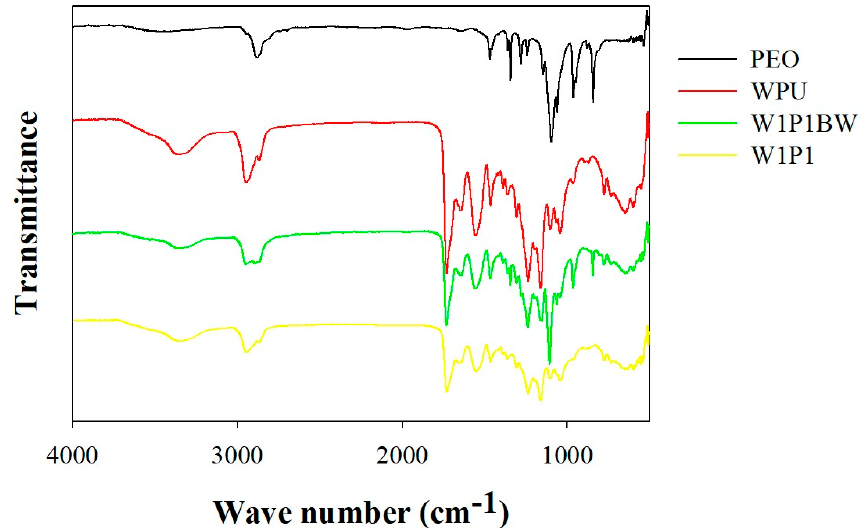
Figure 2. The Fourier transform infrared spectra of the W1P1 nanofibrous membrane (NFM) before and after PBS treatment: A peak centered at approximately 1120 cm − 1 is identified for W1P1BW (W1P1 before wash) and is attributed to the C–O–C stretching vibration of PEO. This peak was negligible in the spectrum obtained after the NFM was washed with PBS (W1P1). In addition, the spectrum of W1P1 revealed the same absorbance as that in the spectrum of pure WPU, implying that washing with PBS was effective for removing PEO from WPU NFMs.